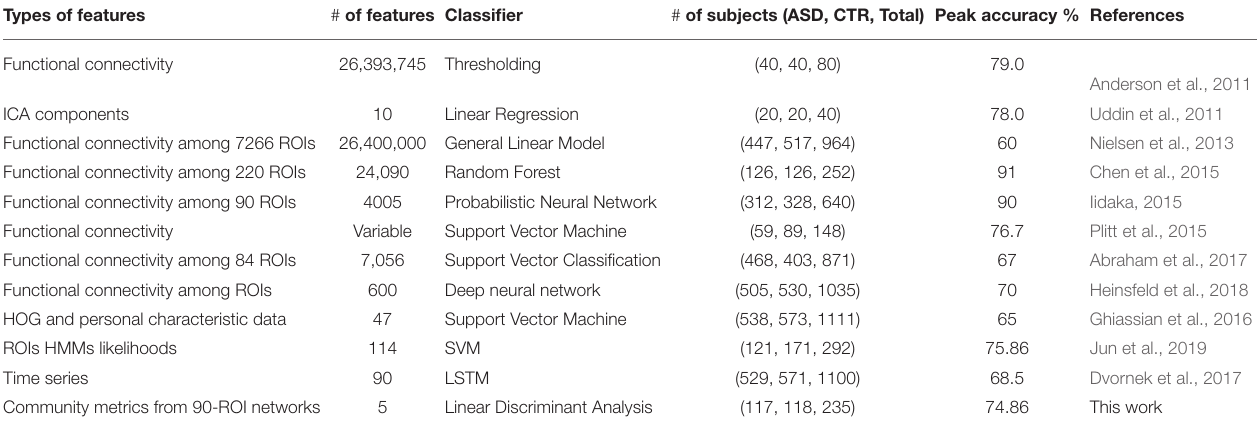
TABLE 6 | Comparing our classification results with recent works. Types of features